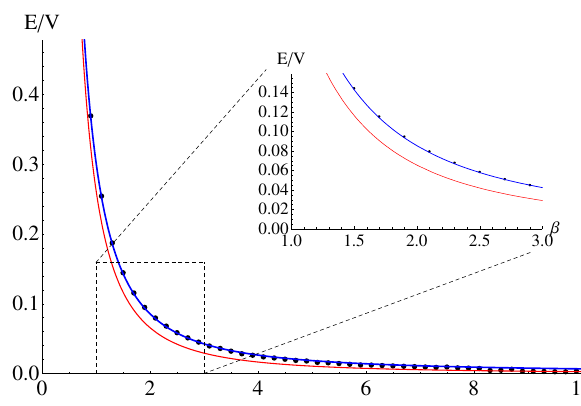
R + 1 Figure 3 . Total energy density 1 d! ! h N ! i of the Unruh radiation, as a function of (cid:12) , com- (cid:12) V 0 puted by integrating (2.19) (black dots). The exact energy (2.8) (with c = 1) is plotted as a blue line (top). The semi-classical energy (2.7) is plotted as a red line (bottom), computable by inte- grating (2.15). The inset shows in more detail the match at the exact level, and the approximation made by taking the semi-classical